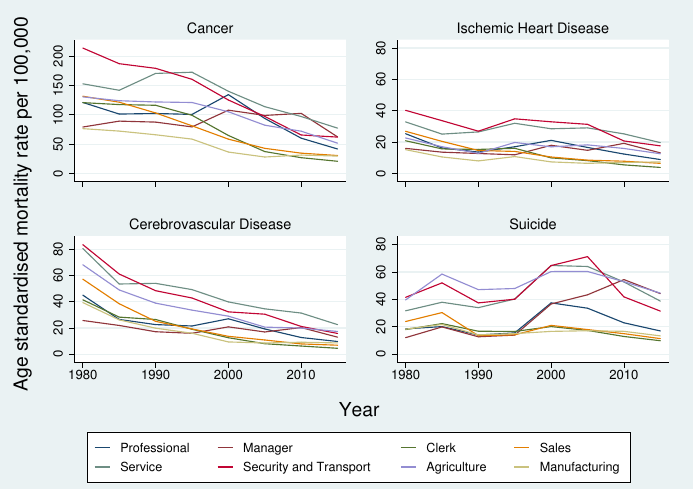
Figure 1. Trend in age-standardised mortality rates per 100,000 by occupation, separately by cause, among Japanese men. Note: Due to a comparatively higher prevalence of cancer mortality compared to the other three causes, a different scale has been used for cancer in the first